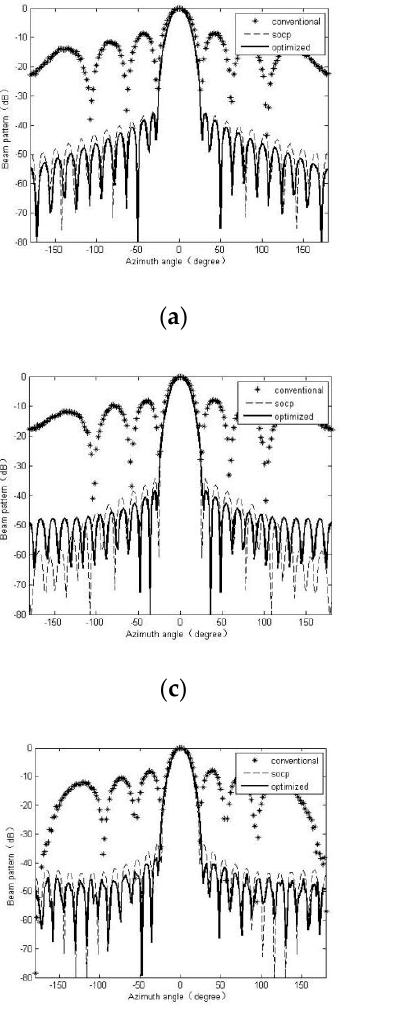
Figure 9. Superposition of measured array manifold at six frequency points.